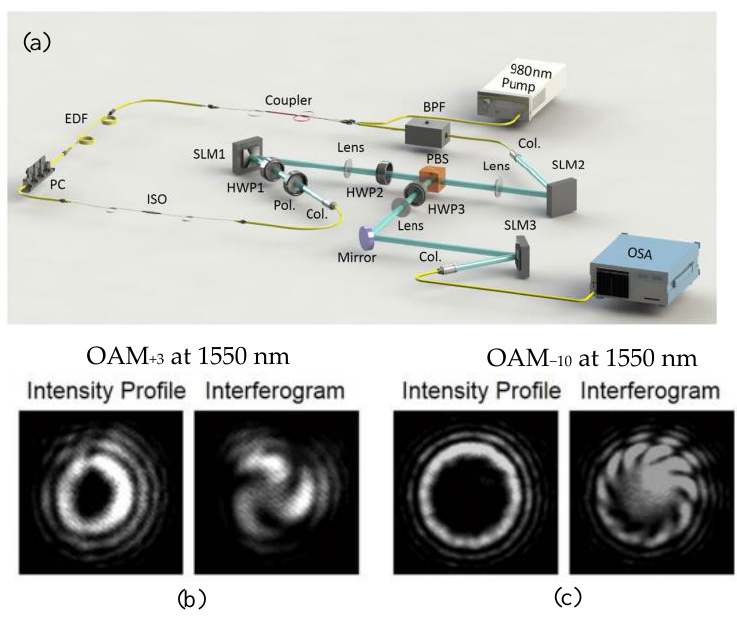
Figure 14. ( a ) Experimental configuration of the twisted light laser. Experimental intensity distribu- tions and interferograms of ( b ) OAM +3 and (c) OAM −10 at 1550 nm (Adapted from an open-access source Ref. [100]).